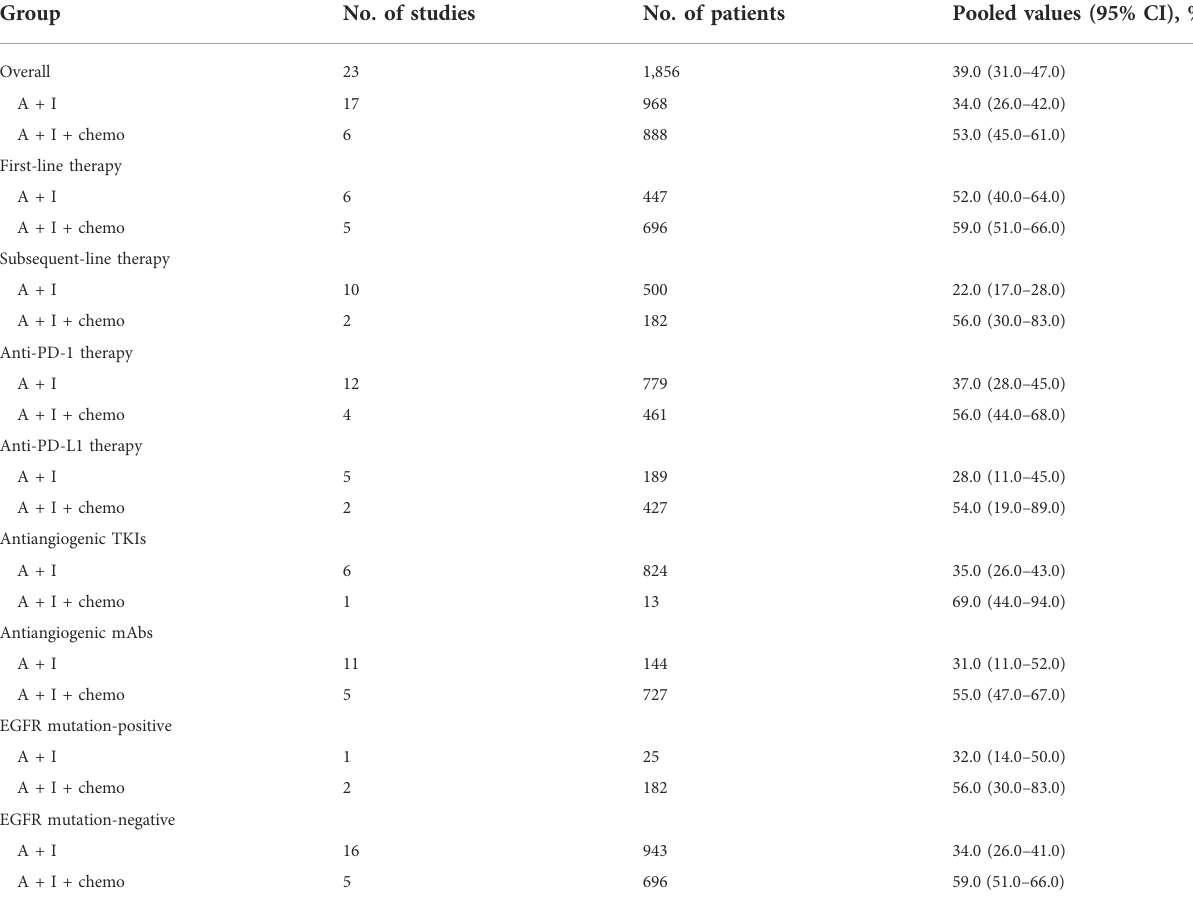
TABLE 2 Objective response rate (ORR) for combined immunotherapy and antiangiogenesis therapy with or without chemotherapy.